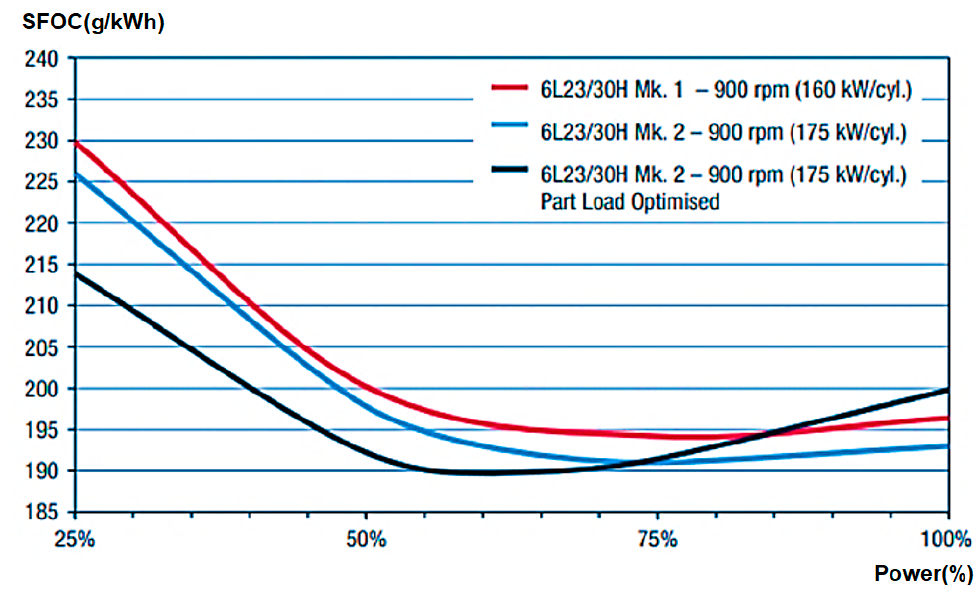
Figure 5. SFOC curve of auxiliary engine [20].